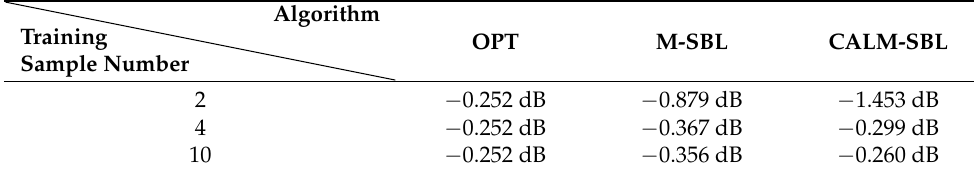
Table 4. The average SINR loss comparison of Figure 7.